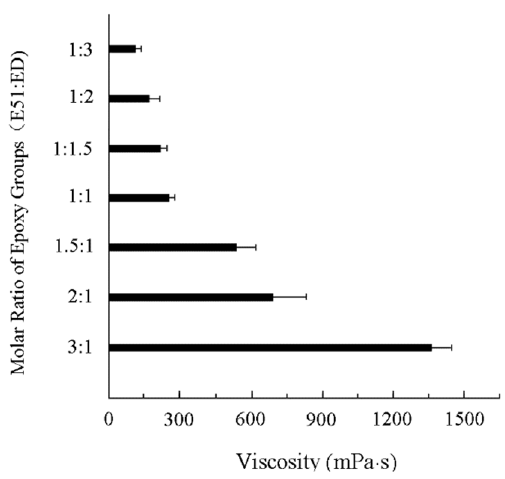
Figure 1. The initial viscosity of the reaction system under different E51 to ED